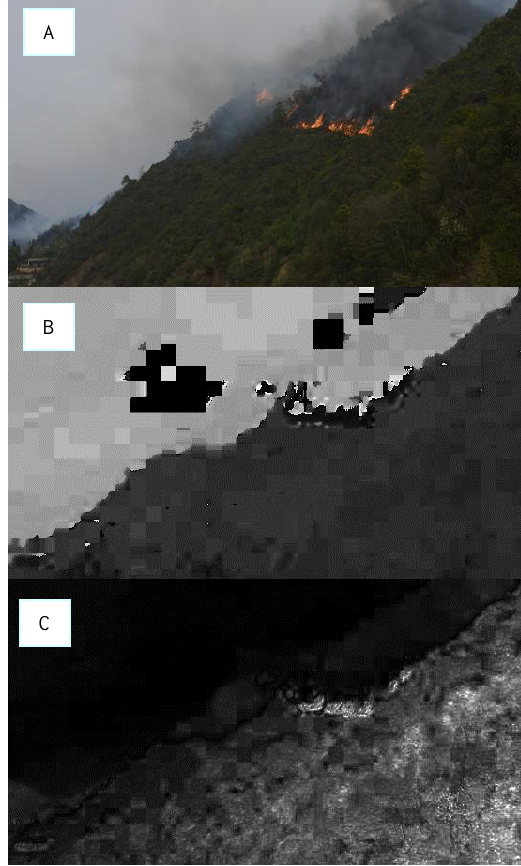
1.3 YCbCr color